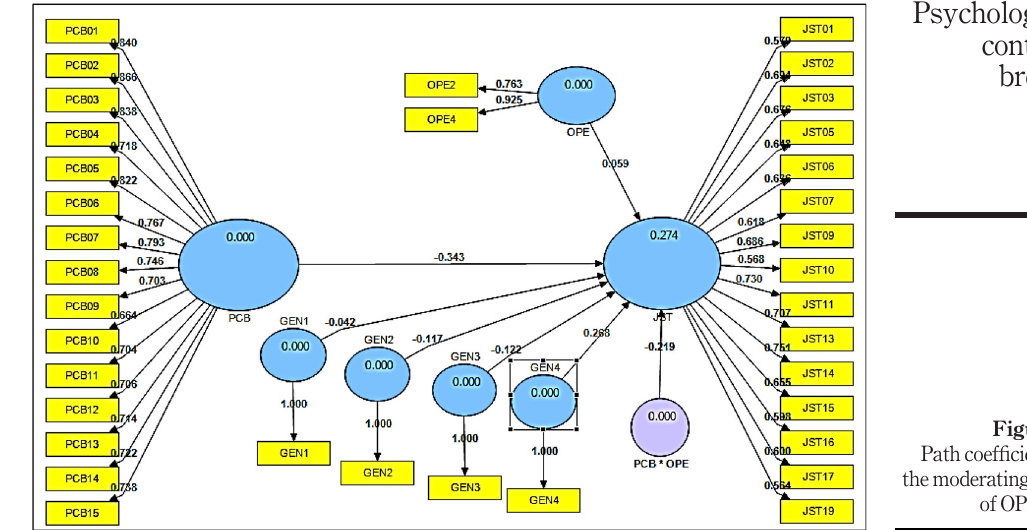
Figure 4. Path coef fi cients of